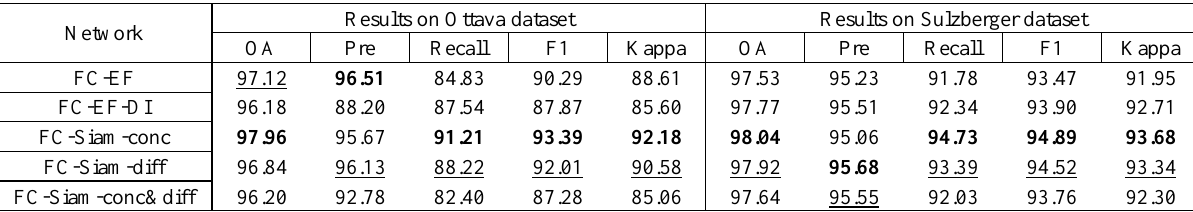
Table 1. Change detection results for different networks on the Ottawa dataset (left) and Sulzberger dataset(right). Pre and F1 representative precision and F1-score respectively. The best results are marked in bold and the second-best results are underlined.